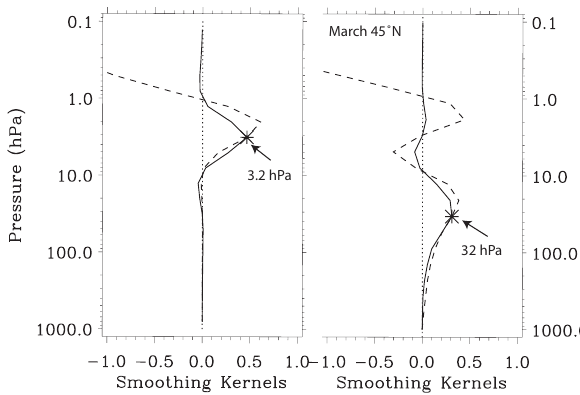
Figure 6. SBUV smoothing kernels at 3.2 and 32 hPa for March at 45˚N. The solid lines apply to fractional changes in layer ozone and the dashed line to absolute changes. We call them averaging and integrating kernels respectively. Though quite different in shape the two kernels produce mathematically the same result.